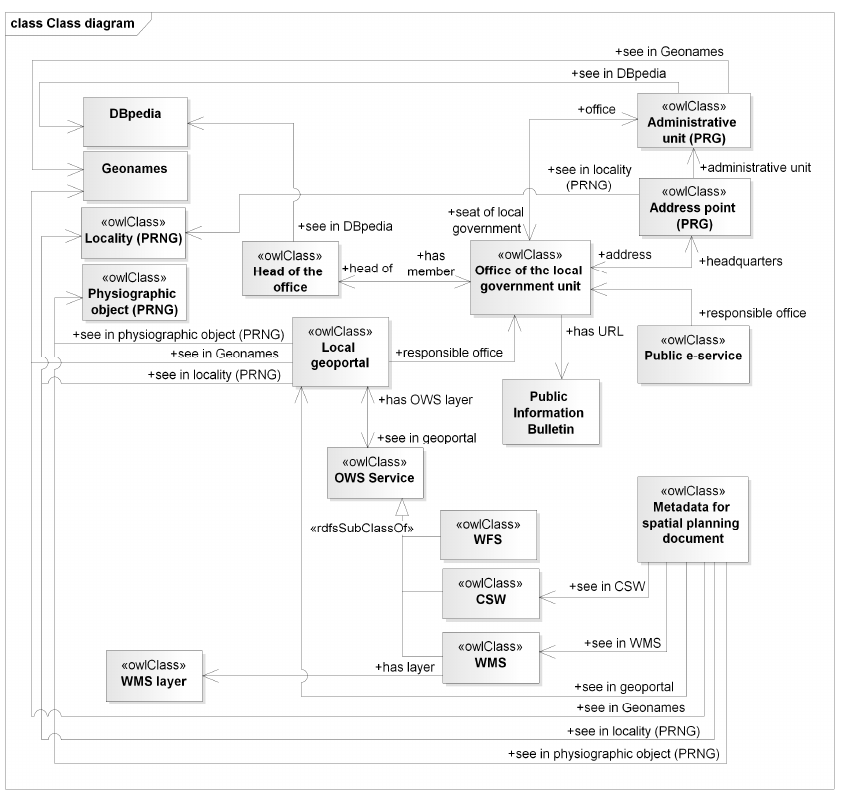
Figure 4. Class diagram showing relations between main ontology classes for prototype of the system.